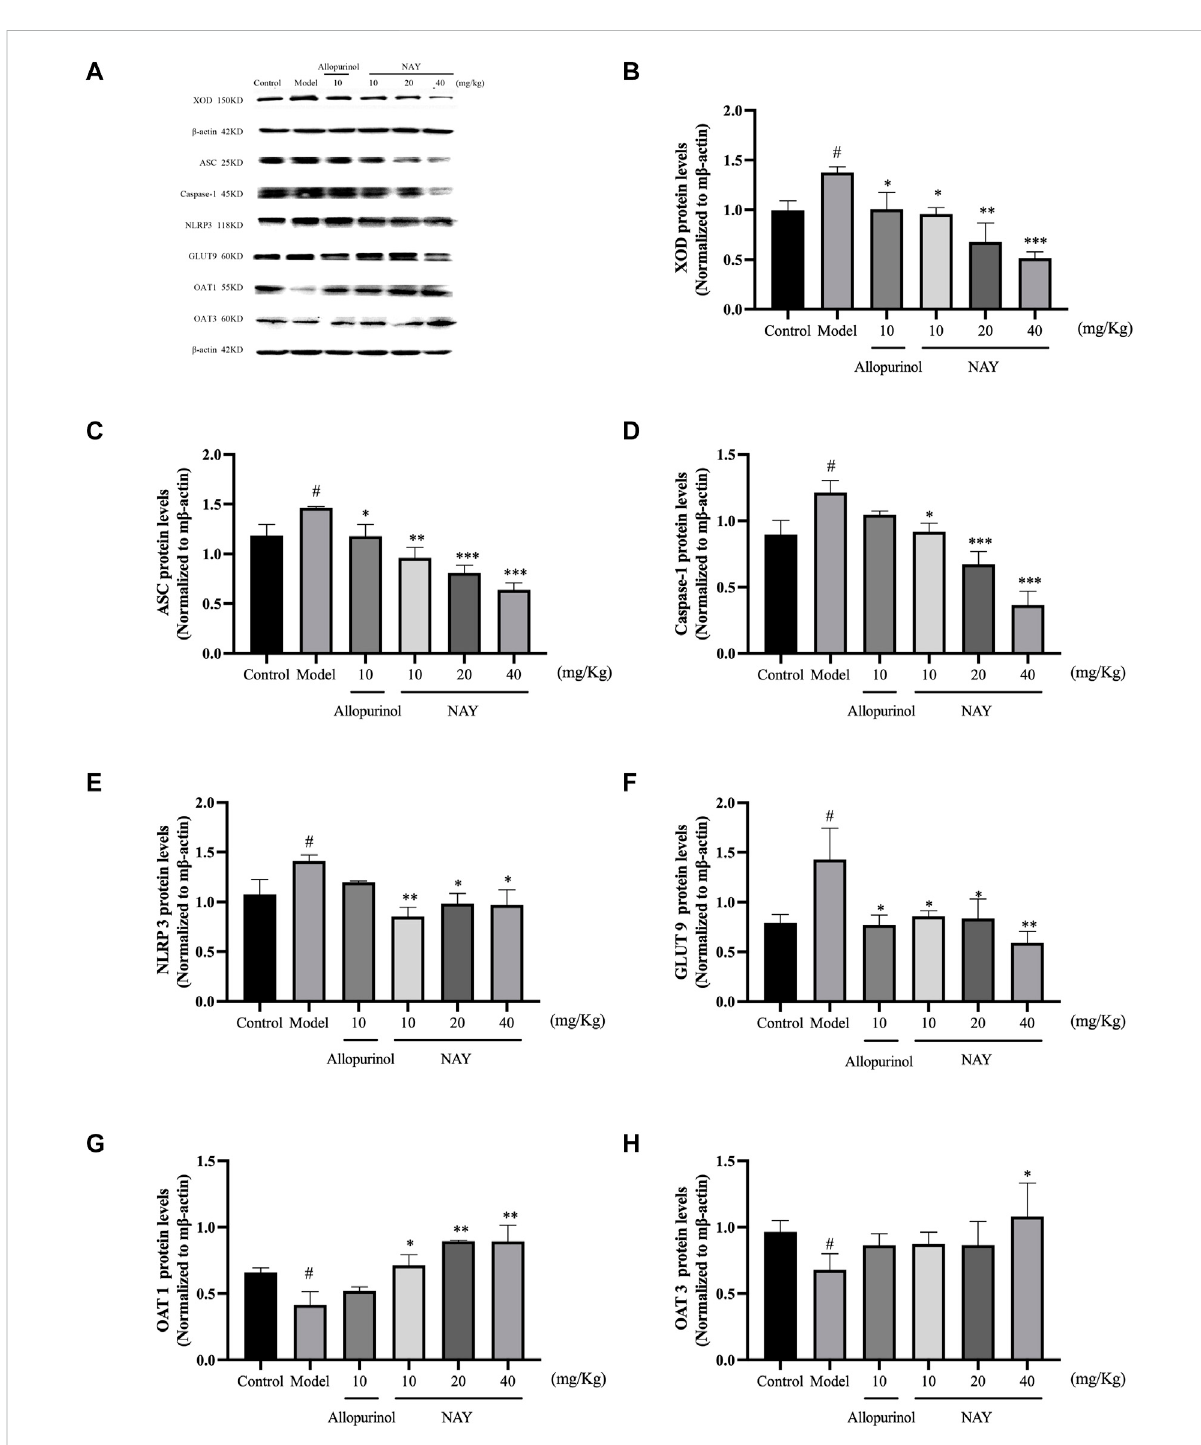
FIGURE 7 Effects of NAY and positive control on protein expression of XOD in liver tissues and protein expression of ASC, Caspase-1, NLRP3, GLUT9, OAT1, and OAT3 in renal tissues (A) . Data were normalized to β -actin (B – H) . (Data were expressed as mean ± S.E.M., n = 3. Compared with the control group, # p < 0.05, ## p < 0.01, and ### p < 0.001. Compared with the model group, * p < 0.05, ** p < 0.01, and *** p <